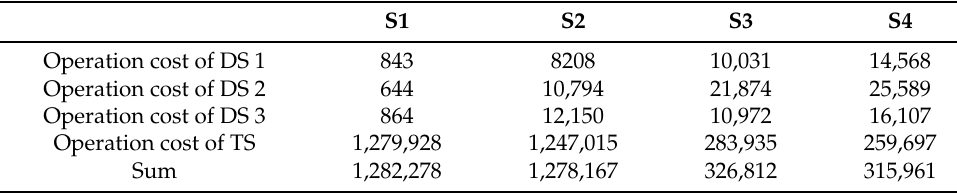
Table 2. Cost comparison between